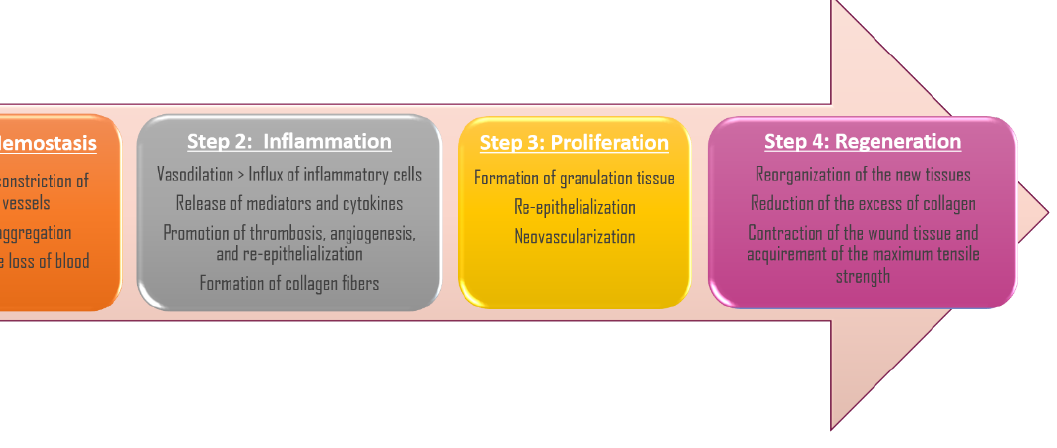
Figure 1. Stages of wound-healing process.